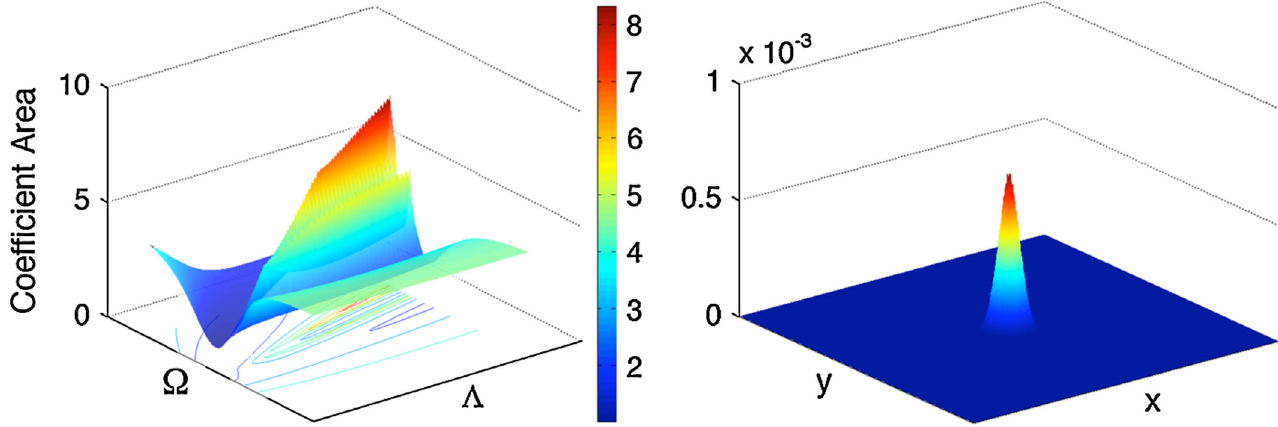
FIG. 6. (Color) The left side is the coefficient area map of the BNL SDL system with (cid:1) 3 (cid:3) (cid:7) (cid:1) (cid:7) 3 (cid:3) and 1 : 0369 (cid:7) (cid:2) (cid:7) 10 : 3694 . On the right is the normalized light intensity pattern at the undulator exit. Intensity is in arbitrary units. Transverse dimension in dimensionless units is (cid:1) 5 : 163 (cid:7) x (cid:7) 5 : 163 and the same for y